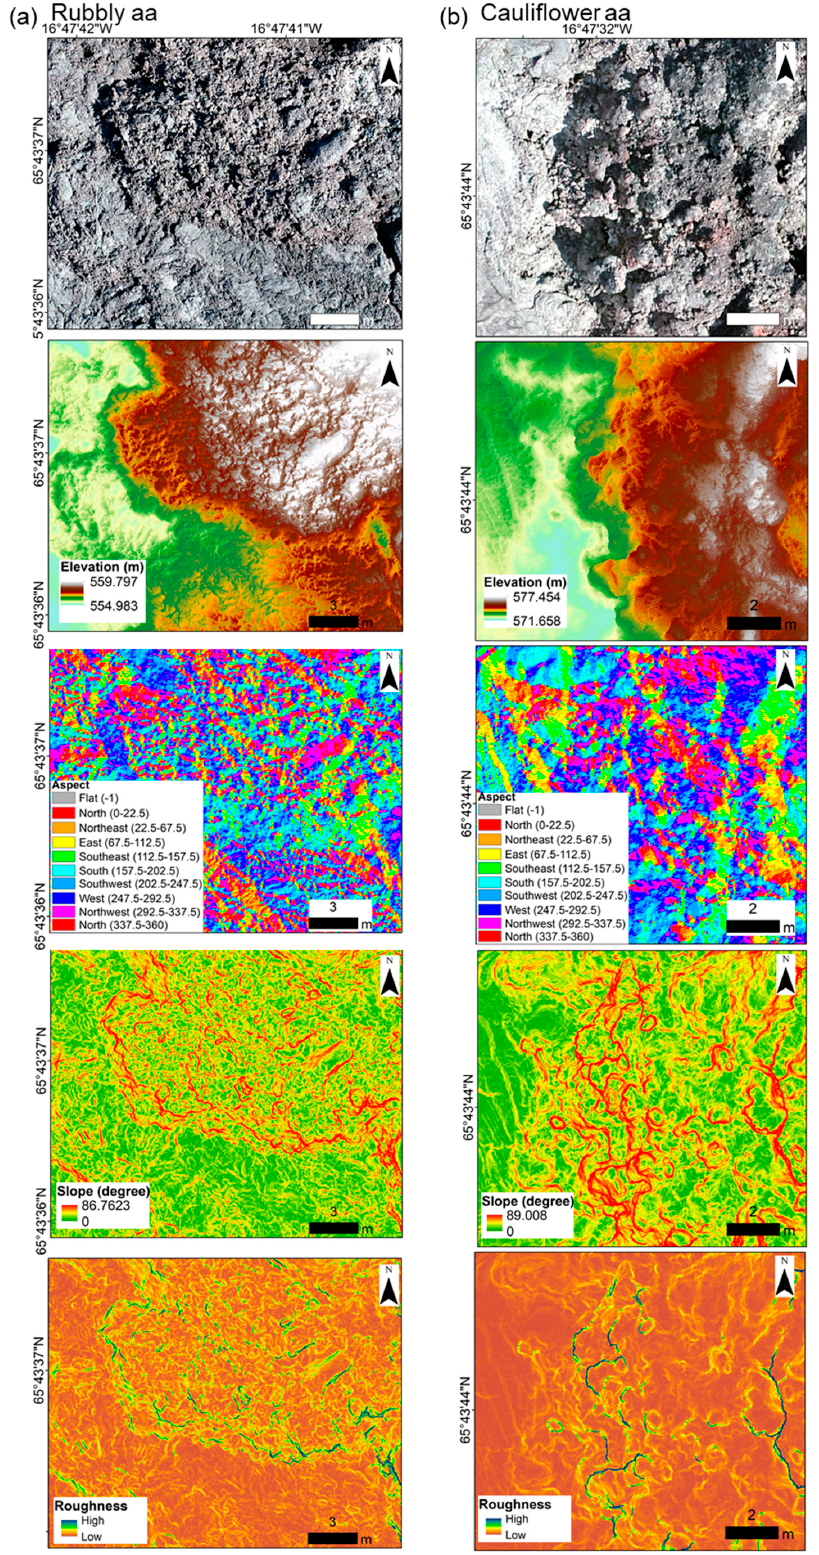
Figure 7. Lava morphologies derived from UAV imaging and photogrammetry for aa flow at Leirhnjúkur fissure volcano lava field in Krafla Caldera, Iceland: ( a ) rubbly aa; ( b ) cauliflower aa. The maps represent orthomosaic, elevation, aspect, slope, and roughness in top-to-bottom order.